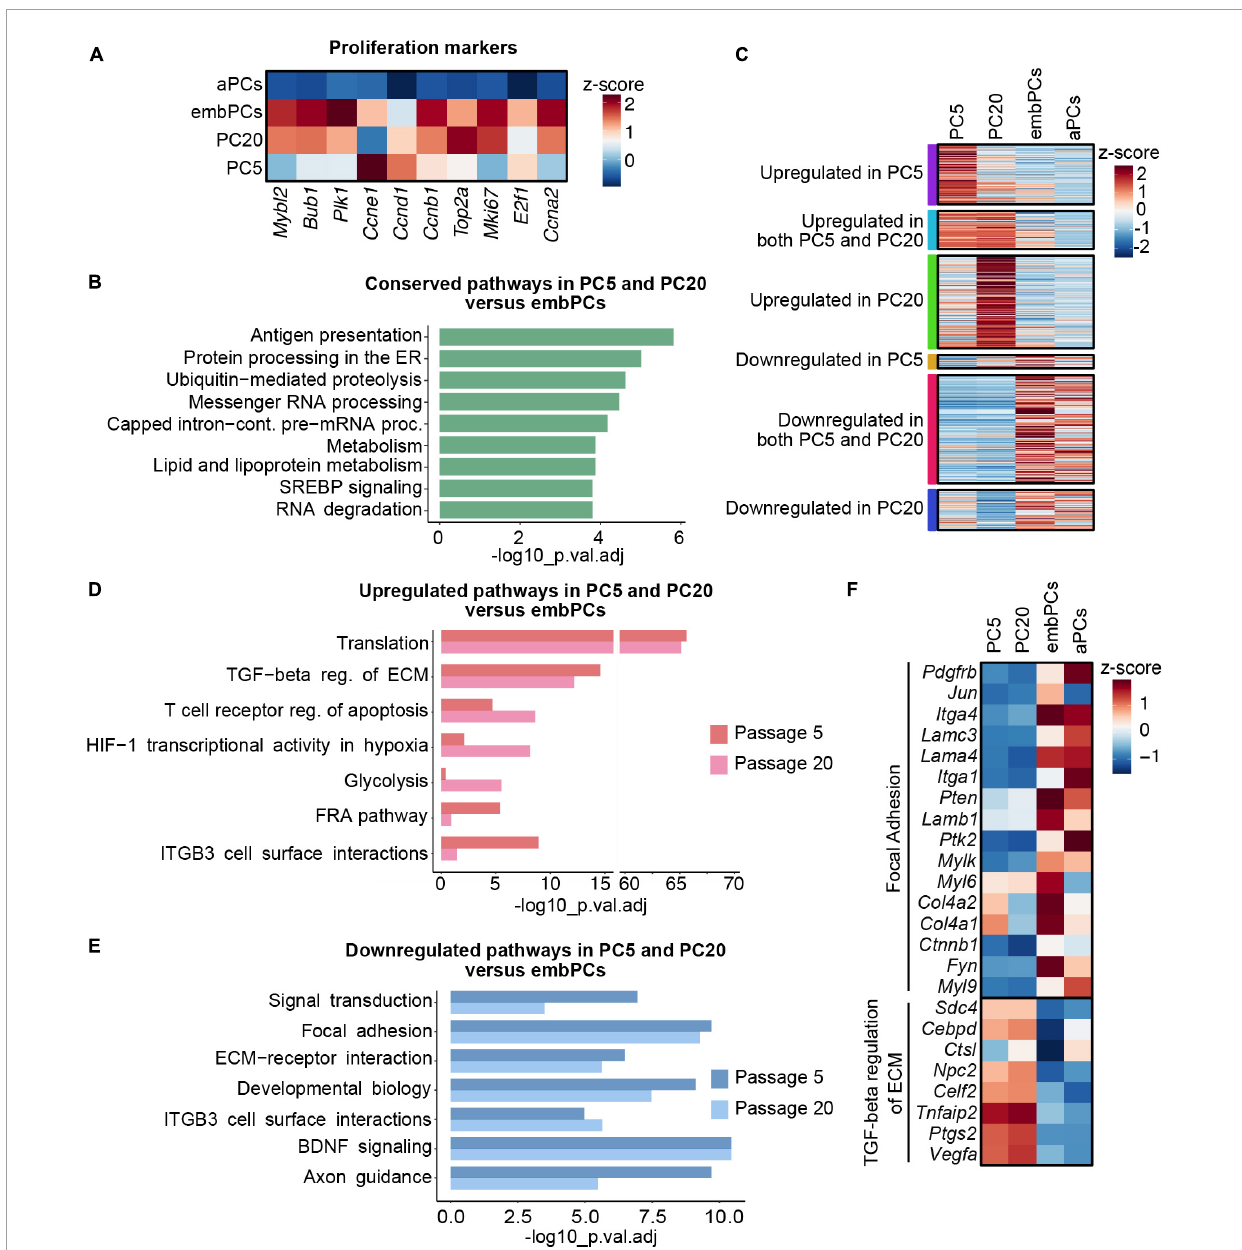
FIGURE3 Extracellular matrix (ECM) and cell surface proteins are deregulated in cultured PCs compared to embPCs. (A) Heatmap depicting the enrichment of cell proliferation markers in PC5, PC20, aPCs, and embPCs. Colors represent the average z-score of a cluster for the indicated gene. (B) BioPlanet annotated pathways conserved in cultured PCs and embPCs. (C) Heatmap of selected genes significantly enriched in PC5, PC20, embPCs, and aPCs. Colored boxes on the left indicate if the genes represented in the plot are significantly deregulated in one or more of the cell clusters. (D) BioPlanet annotated pathways significantly upregulated in PC5 and/or PC20 in comparison to embPCs. (E) BioPlanet annotated pathways significantly downregulated in PC5 and PC20 in comparison to embPCs. (F) Heatmap depicting the enrichment of “focal adhesion” and “TGF-beta regulation of ECM” genes across PC5, PC20, aPCs, and embPCs. Colors represent the average z-score of a cluster for the indicated gene. aPCs, adult brain pericytes; embPCs, embryonic brain pericytes; PCs, pericytes; PC5, passage 5 pericytes; PC20, passage 20